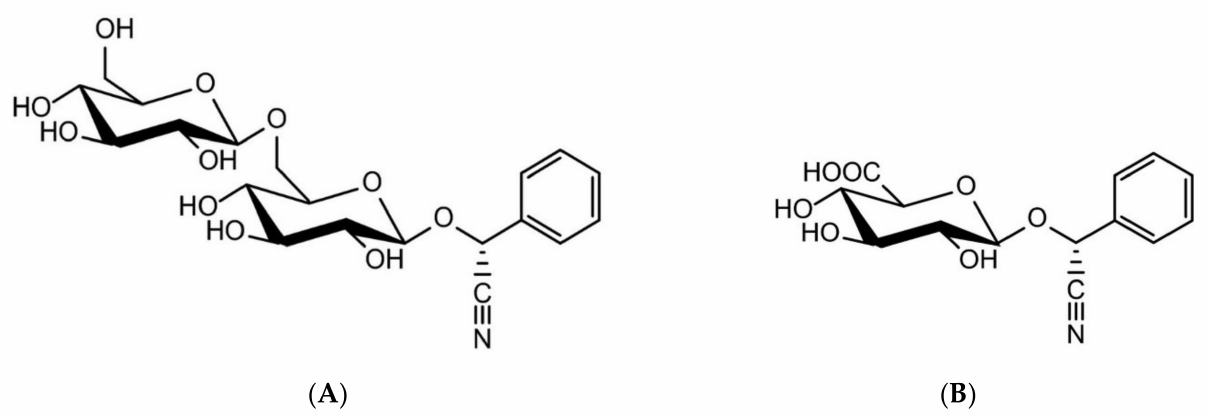
Figure 1. Chemical structures of amygdalin ( A ) and laetrile ( B )